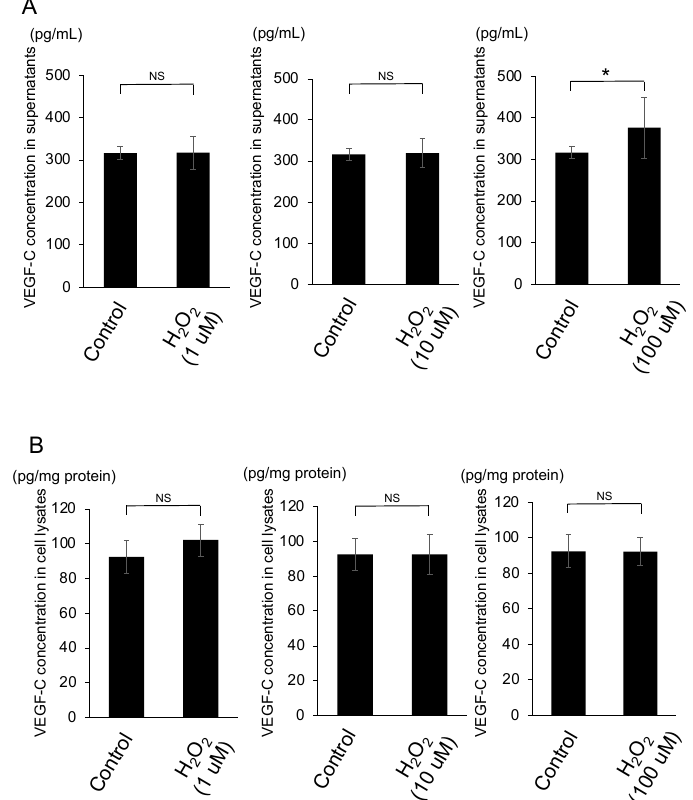
Figure 3. Effect of oxidative stress on VEGF-C concentrations in trabecular meshwork cells. Trabecular meshwork cells were cultured in media with H 2 O 2 (0, 1, 10, 100 μ M) for 24 h. Additionally, VEGF-C concentrations in the supernatants ( A ) and the cell lysates ( B ) were detected using ELISA. VEGF-C concentrations in the supernatants with 100 μ M H 2 O 2 ( n = 4) but not 1, 10 μ M H 2 O 2 ( n = 4 in each group) were significantly elevated compared with control (0 μ M H 2 O 2 ) ( n = 6) (* p < 0.05). VEGF-C concentrations in the cell lysates with all concentrations of H 2 O 2 (1, 10, 100 μ M) ( n = 4 in each group) were not significantly different from control (0 μ M H 2 O 2 ) ( n = 6) ( p > 0.05). VEGF-C concentrations in both supernatants and cell lysates of TM cells which had been cultured in low oxygen (1% oxygen concentration) were significantly higher than those in stationary oxygen (20% oxygen concentration) (supernatants: n = 6 in each group, p < 0.05; cell lysates: n = 6 in each group, p < 0.01) (Figure 4A,B).